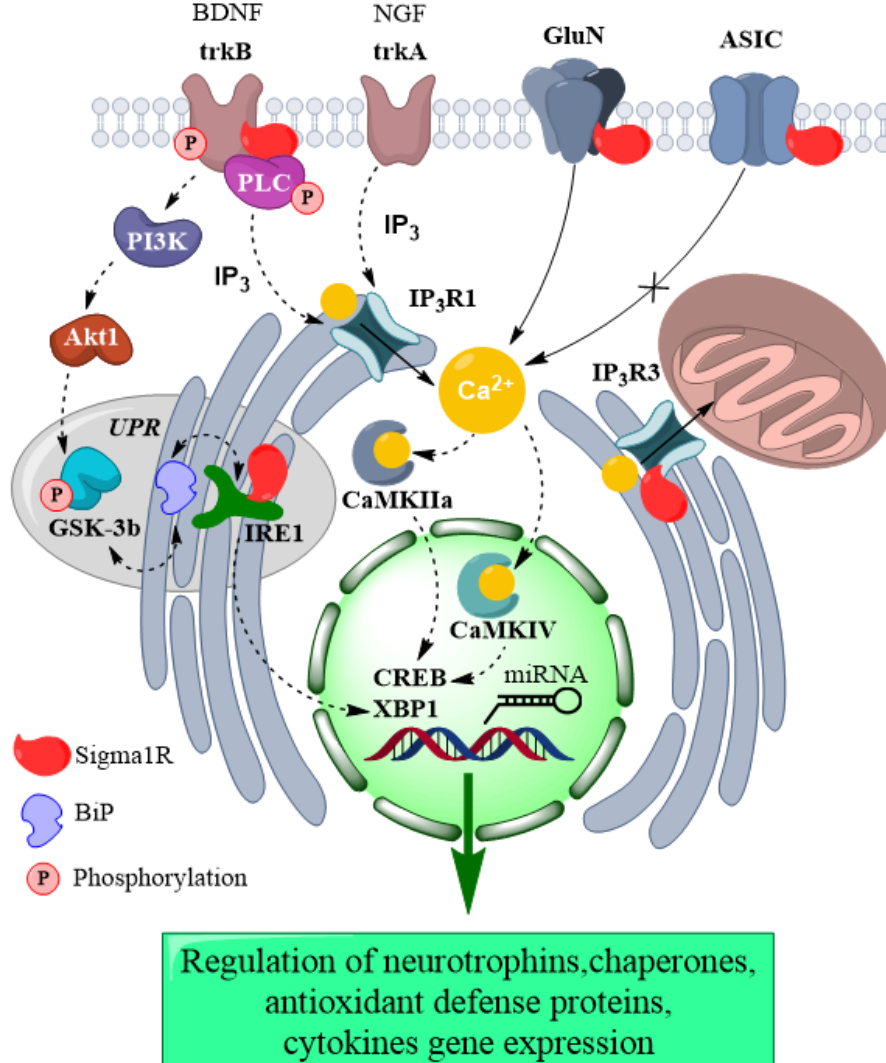
Figure 1. The contribution of Sigma1R activation in intracellular mechanisms of the antidepressant e ff ect. The figure represents chaperone interactions of Sigma1R and functional consequences on proteins triggered by Sigma1R activation. Interaction of Sigma1R with BDNF receptor, GluN, Ca 2 + channels, and ER stress sensor promotes activation of signal cascades and Ca 2 + -dependent proteins. These processes jointly with Sigma1R-dependent epigenetic regulation cause changes in expression of genes of neurotrophins, chaperones, proteins of antioxidant defense, and cytokines that provide the antidepressant e ff ect. Plain arrow—Ca 2 + flux; dashed arrow—Sigma1R-mediated influences. Akt1—RAC-alpha serine / threonine-protein